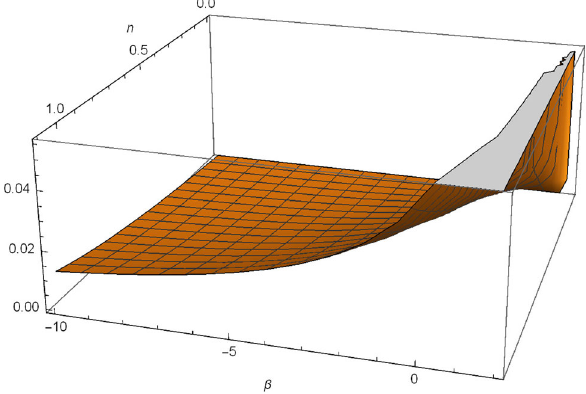
Fig. 4 The behavior of the spectral index parameter is shown. We use theranges n = [ 0 , 4 ] and β = [ 0 , 2 ] withthevalues γ = 0 . 018, N = 60